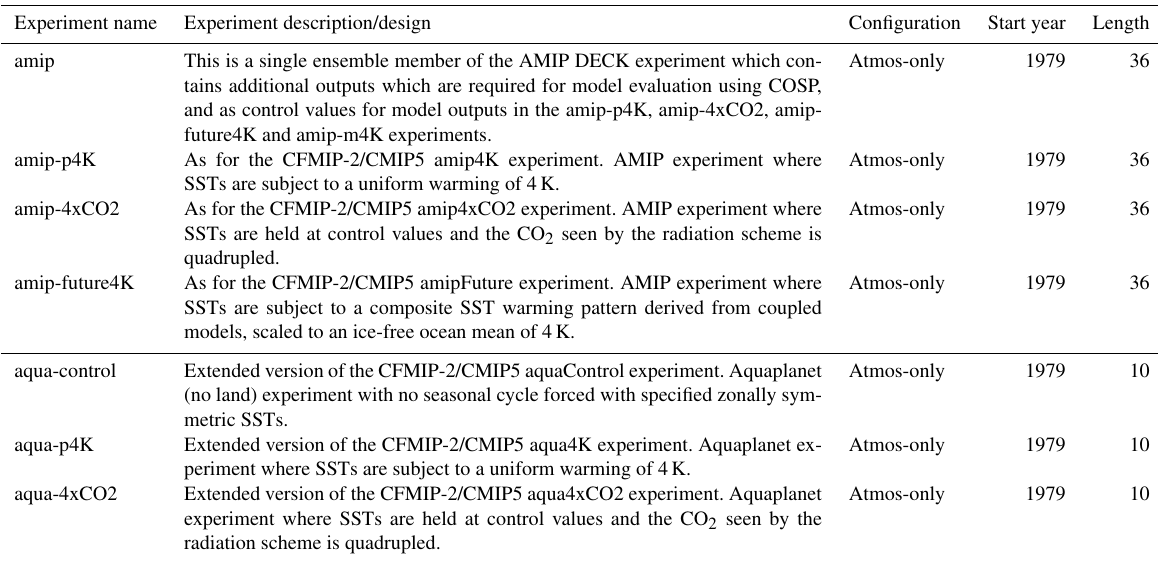
Table 1. Summary of CFMIP-3/CMIP6 Tier 1